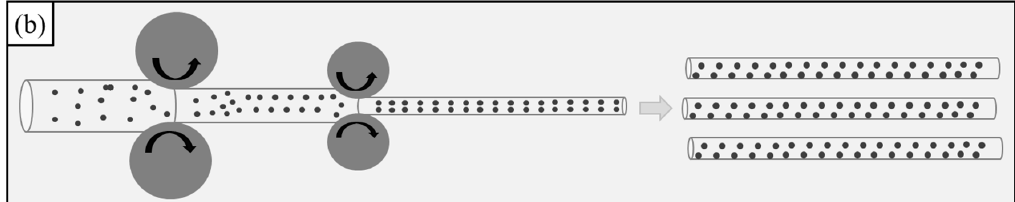
Figure 1. Schematic illustration of the fabrication of TiC p /Al-5Mg composite fillers: ( a ) Al-5Mg alloy and its composites preparation; ( b ) multi-pass rolling.